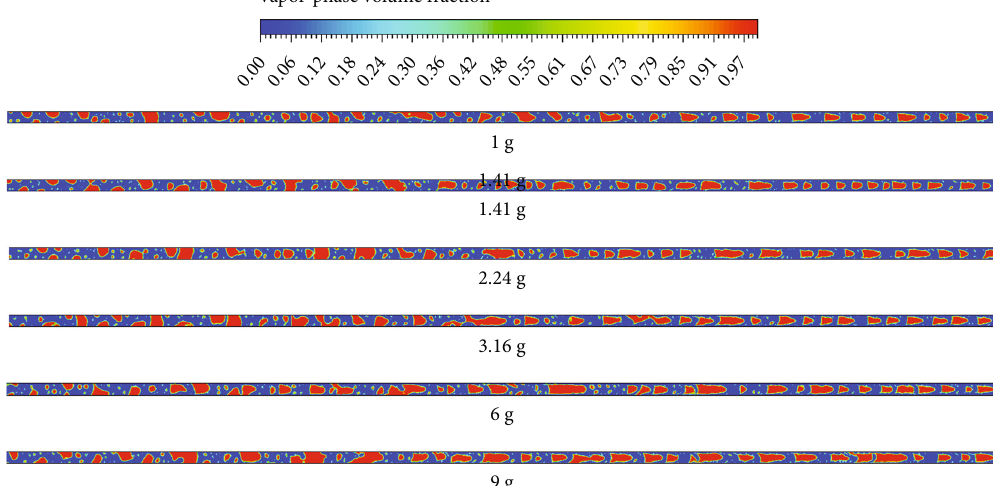
Figure 10: Diagram of boiling fl ow patterns of 0.1% nano fl uid at gravity levels from 1g to 9 g (The gravity direction is opposite to the fl ow